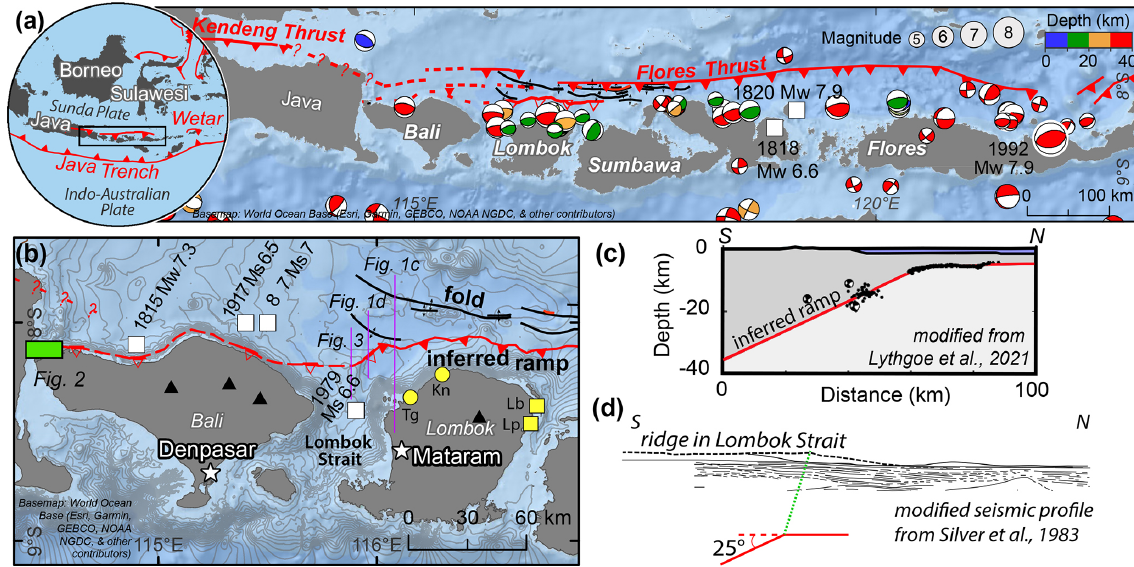
Figure 1. Regional setting of the Flores Thrust and its subsurface ramp-flat geometry. (a) Circle – the Flores back-arc thrust system, which is located along the northern edge of the Lesser Sunda Islands. The thrust is composed of two segments: the Wetar Thrust to the east and the Flores Thrust to the west (black rectangle). Seismicity (USGS earthquake catalog, 1976–2021) and focal mechanism solutions (GCMT, 1976–2021) show that the Flores Thrust is seismically active. The M w 7.9 Flores Island tsunamigenic earthquake is the largest earthquake on record for this system and occurred at the eastern end of the thrust. (b) The western part of the Flores Thrust, which has generated historical tsunamigenic earthquakes (white rectangles; https://www.ngdc.noaa.gov/, last access: 10 September 2021; Hamzah et al., 2000; Rastogi and Jaiswal, 2006; Musson, 2012; Nguyen et al., 2015; Griffin et al., 2019). Yellow squares and circles: towns where a tsunami was reported following the 28 July 2018 M w 6.4 and 5 August 2018 M w 6.9 events, respectively. Tg – Tanjung; Kn – Kayangan; Lb – Labuhan Pandan; Lp – Leper. We interpret that the blind ramp mapped at Lombok (Lythgoe et al., 2021) extends westwards based on the seafloor morphology and uplifted terraces in the northwestern part of Bali (green rectangle; Fig. 2). Basemaps – World Ocean Base. The map extent of (b) reflects the coverage of grid layer 1 (L1) used in the tsunami modeling. The basemap of (b) with only contour lines overlain is shown in Fig. S1 in the Supplement. (c) The geometry of the blind fault ramp is constrained by the seismicity of the 2018 Lombok earthquake sequence (Lythgoe et al., 2021). (d) Gentle folds interpreted by Silver et al. (1983) based on a seismic profile across the Lombok Strait. Below the profile we show our inferred location for the fault